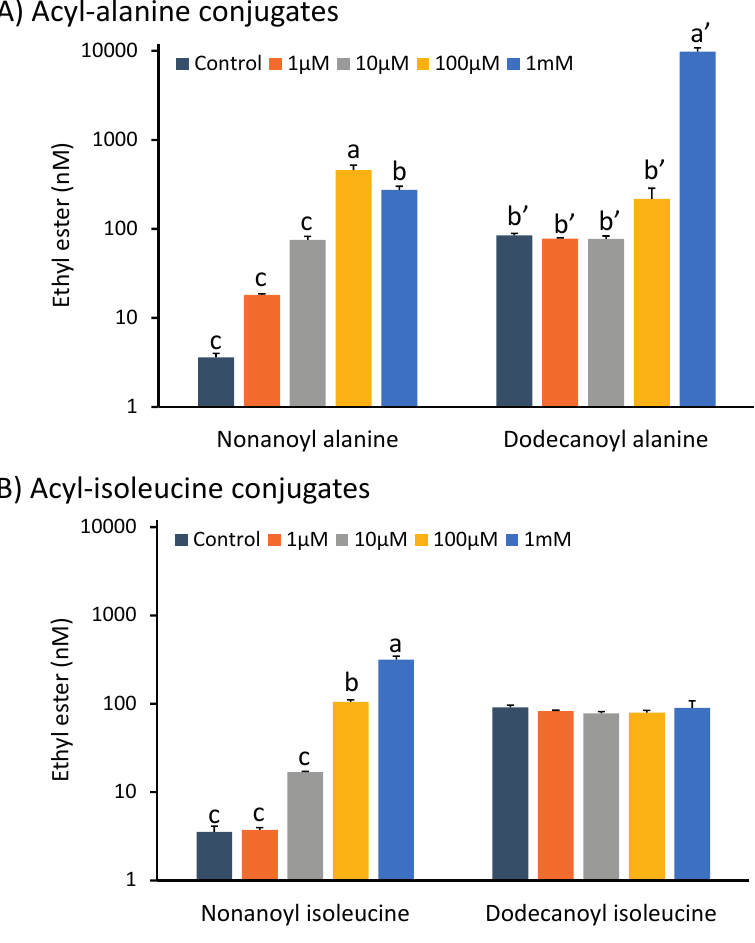
Figure 2. ( A ) Ethyl nonanoate and ethyl dodecanoate concentrations in model wines produced after the addition of increasing amounts of acyl-alanine conjugates to the MGJM. ( B ) Ethyl nonanoate and ethyl dodecanoate concentrations in model wines produced after the addition of increasing amounts of acyl-isoleucine conjugates to the MGJM. Histograms represent the mean values (n = 3) and error bars show standard errors. Different letters (e.g., a, b, c or a ʹ , b ʹ ) denote significant differences between treatments at p < 0.05 using